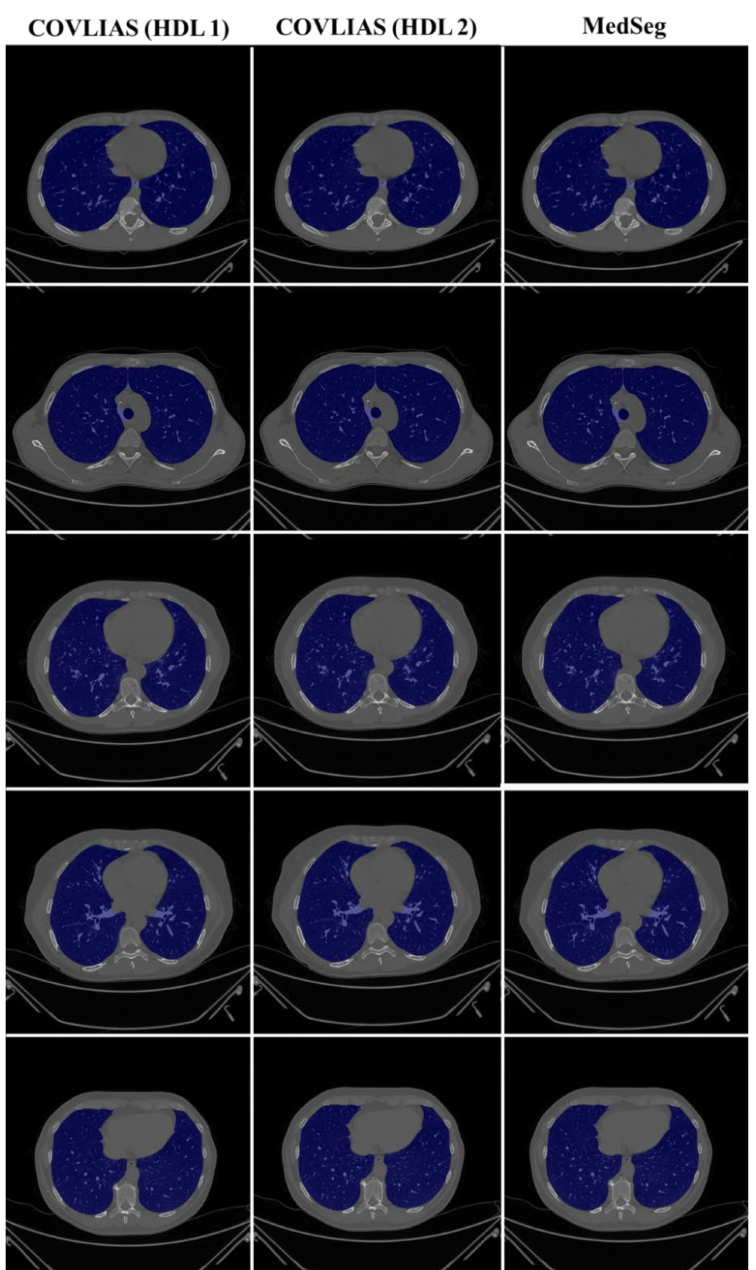
Figure 21. COVLIAS vs. MedSeg: Segmented mask (blue) on the Control CT lung image (large